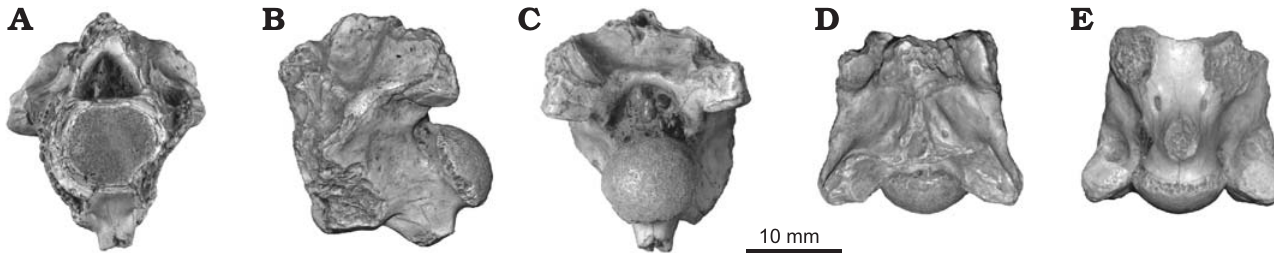
Fig. 7. Vertebra of an indeterminate snake CNRST-SUNY 324 from the Eocene Tamaguélelt Formation, Mali; in anterior ( A ), lateral ( B ), posterior ( C ), and ventral ( D )